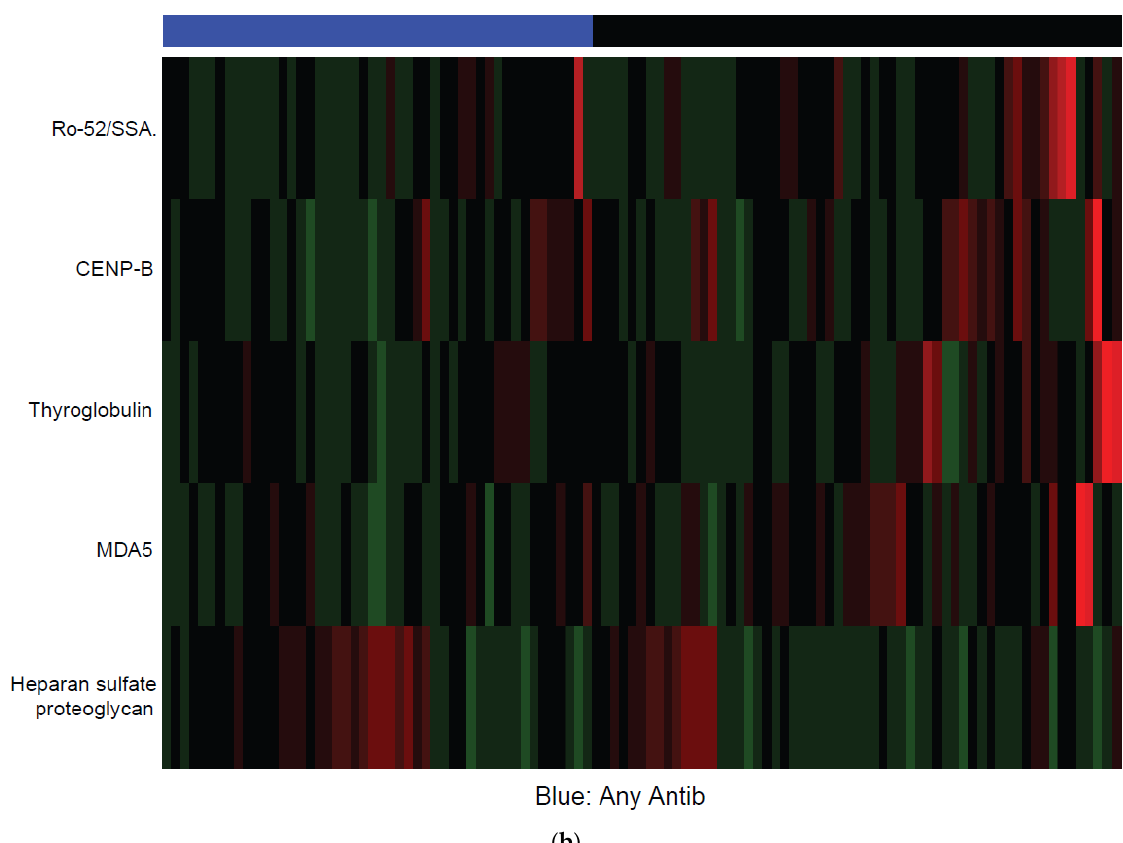
Figure 3. Heatmaps of antibodies with statistically significant differences ( p < 0.05) according to antibiotic exposure: ( a ) Z − Score Baseline antibodies; ( b ) Z − Score 6 week antibodies.